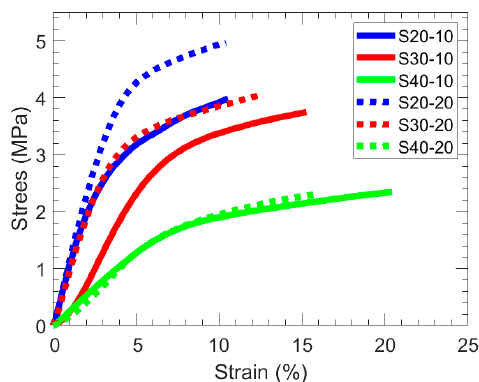
Figure 4. Representative stress–strain curves for (solid) SX-10 and (dotted) SX-20